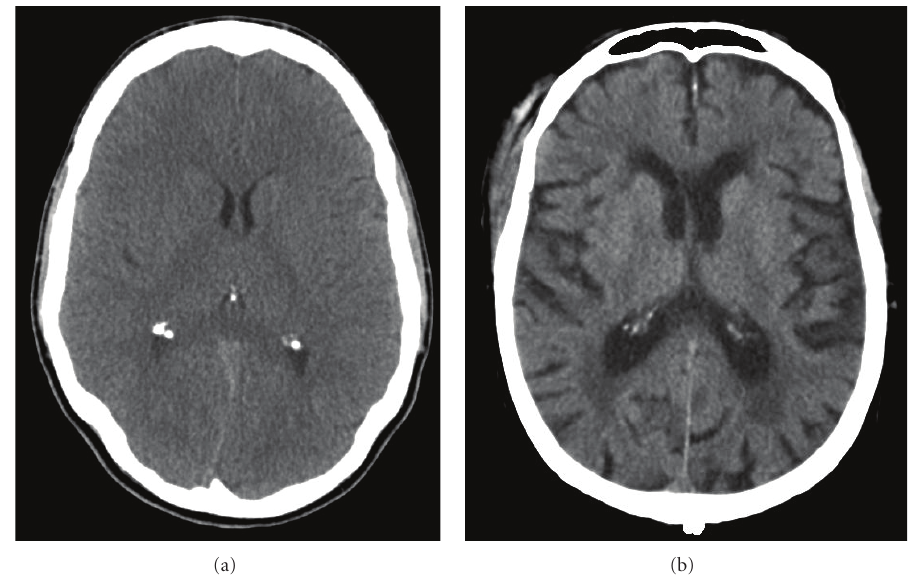
Figure 3: Di ff erences in ventricular size in (a) young and (b) elderly